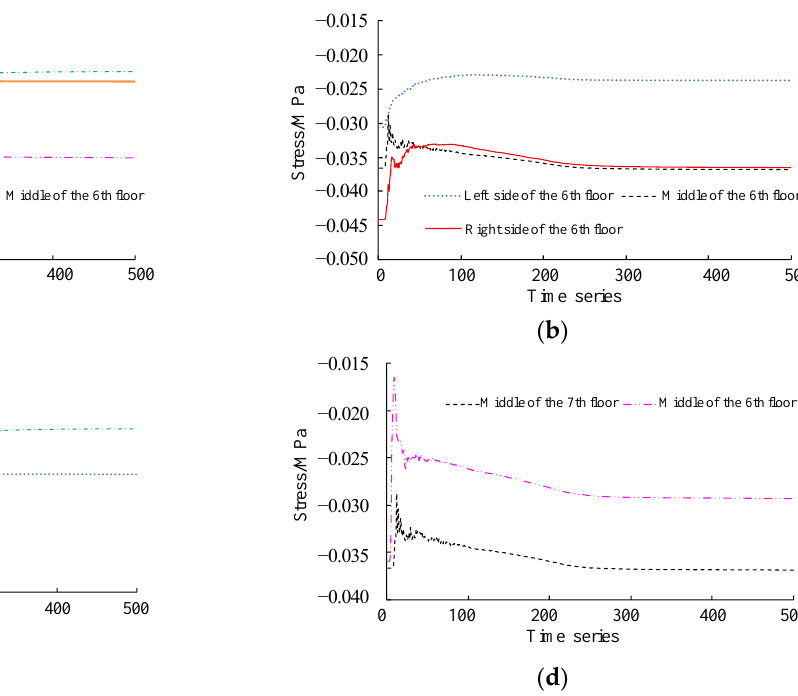
Figure 10. Static load horizontal stress of bottom plate after excavation of the sixth layer. ( a ) 6th layer; ( b ) 7th layer; ( c ) Left side of roadway floor; ( d ) Middle of roadway floor.